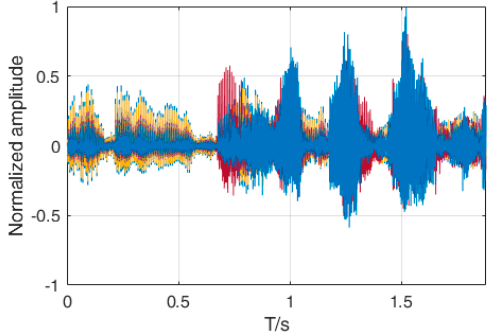
Figure 5. Eight − channel measured mixed signal in the simulative study. Figure 5. Eight-channel measured mixed signal in the simulative study.